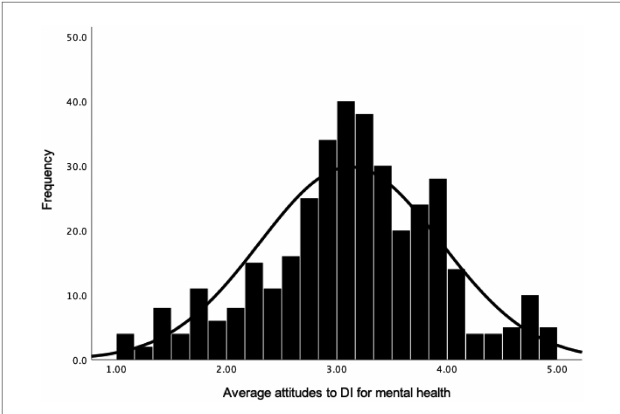
FIGURE 3 Frequency distribution with a normal curve of average attitude towards DI for mental health